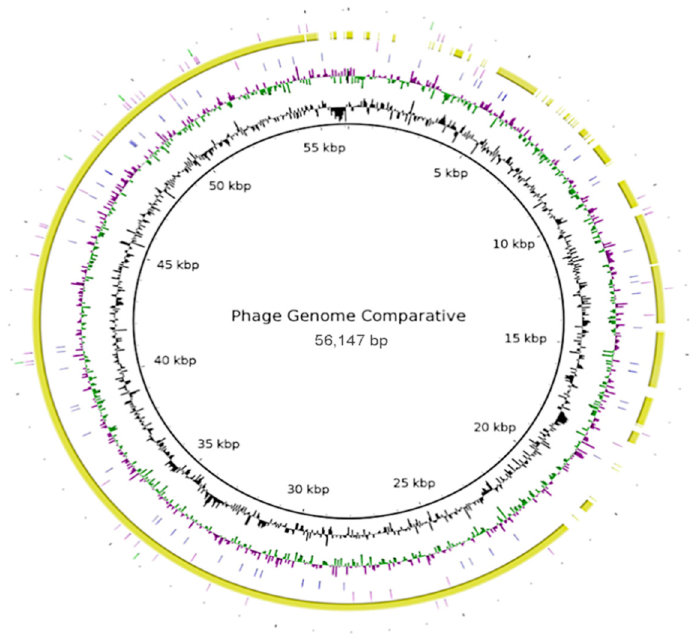
Figure 2. Comparison of bacteriophage genomes used for biocontrol of proteobacteria diseases present in agricultural crops. Complete genomes of bacteriophages were obtained from NCBI (Supplementary Materials). Template sequence was phage Sano; % GC content (black) is shown. Xanthomonas phage phiXc10 (blue) and Ralstonia phage RSM3 (pink) show nucleotide sequence identity conservation <30%. Phage Salvo (yellow) shows identity about 70%, and Agrobacterium phage Atu_ph07 (green). Genomes were compared in Brig version 0.95 software, Brisbane, Australia (http://sourceforge.net/projects/brig/, accessed on 8 September 2022).